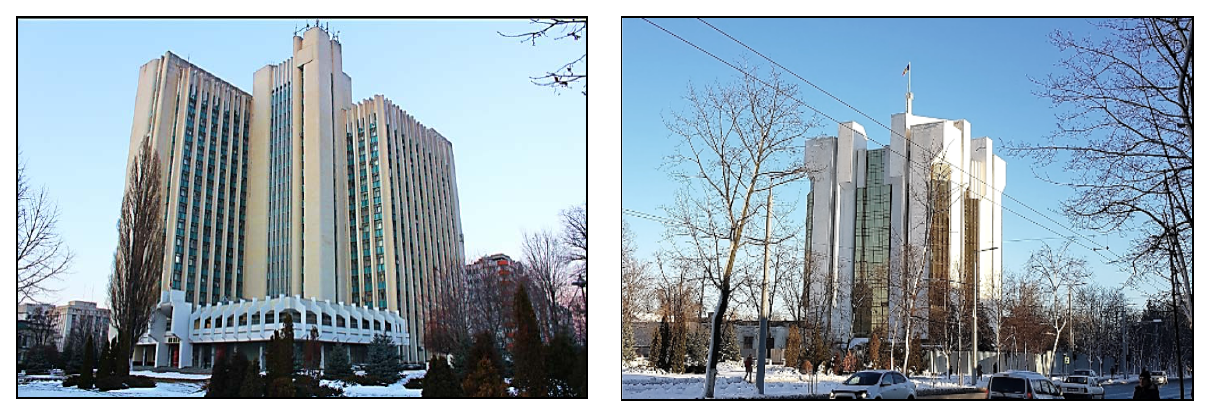
Figure 10. The Ministry of Agriculture, 1980. Figure 11. The Supreme Council,